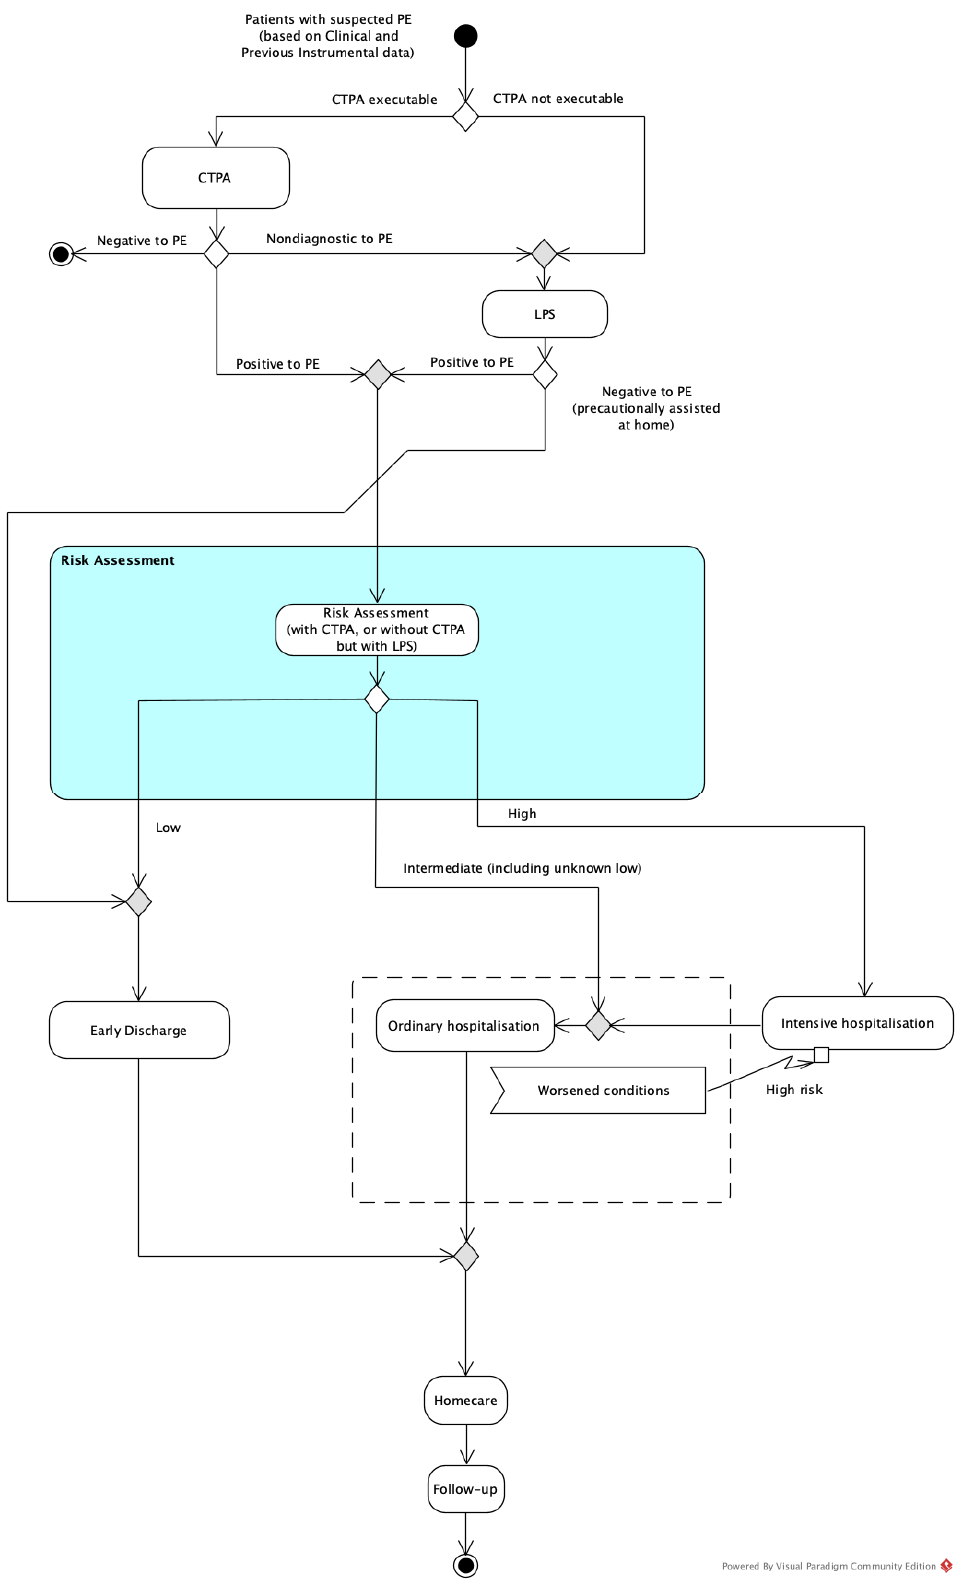
Figure 2. Representation of the LPS pathway: in the scenario where LPS is performed, in the case of non-conclusive or not-executable CTPA, the patient is precautionarily assisted at home if PE is negative, whereas they are admitted to the best risk-based hospitalisation regimen if PE is positive.